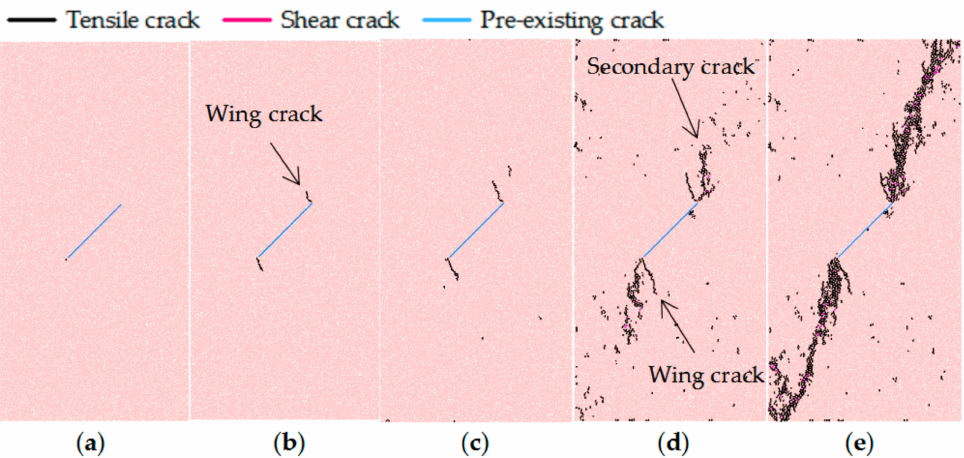
Figure 9. Dynamic failure process of simulated granite sample with single closed crack: ( a ) σ = σ ci ; ( b ) σ ci < σ < σ cd ; ( c ) σ = σ cd ; ( d ) σ cd < σ < σ cr ; ( e ) σ cr < σ